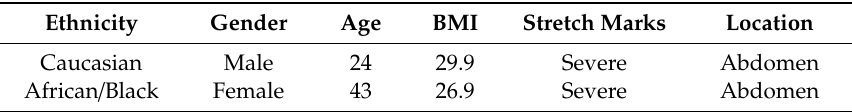
Table 2. Skin samples used for di ff usion studies. Samples were taken from the same location (abdomen) and with similar scarring (severe); however, the age, gender, and ethnicity were di ff erent between the samples. This was done purposely to determine if the intake of miconazole vesicles would act di ff erently when alternative factors were introduced, and to compare these potential di ff erences with those of a marketed cream